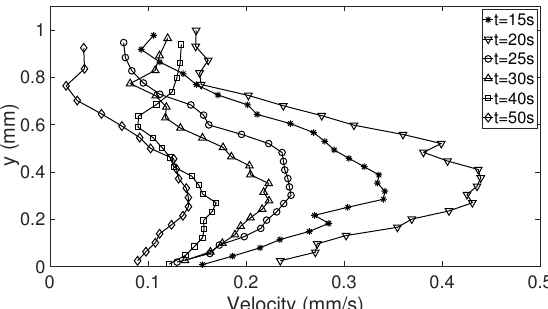
Figure 9. The magnitude of the velocity along the symmetry line for T plate = 333.15 K (Case 1) when t = 20–50 s.